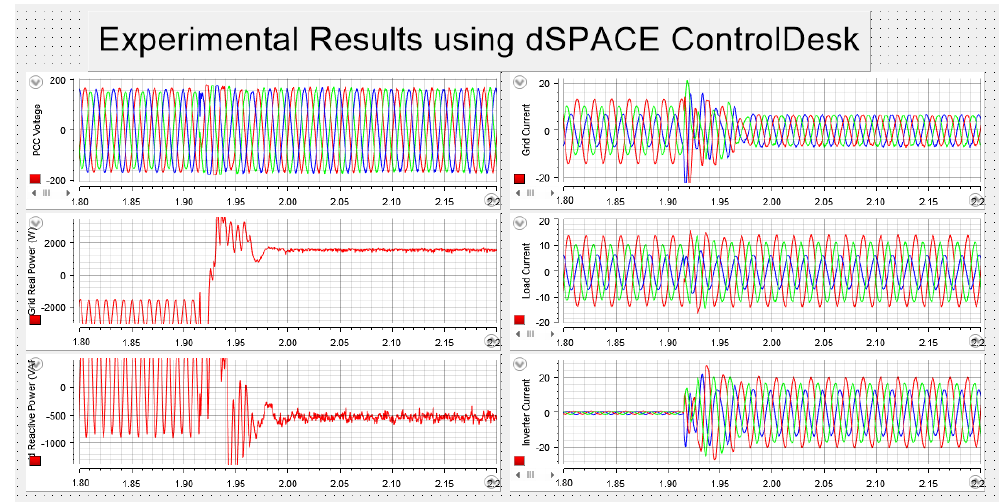
Figure 18. Experimental results at P = 1.5 kW, Q = 500 var using dSPACE Control